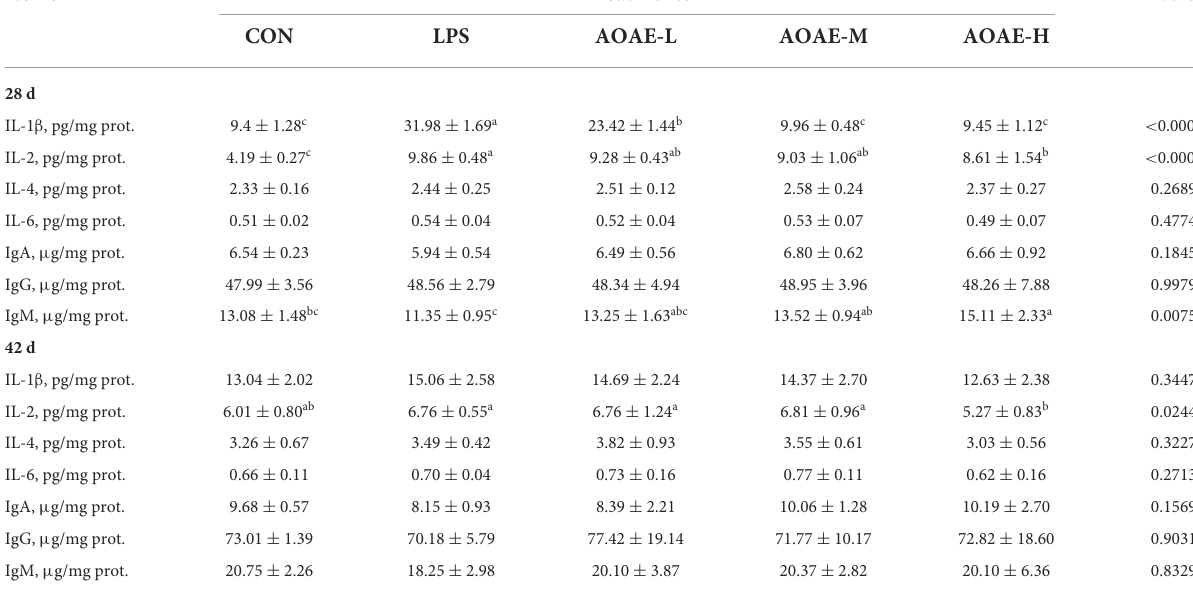
TABLE 6 Effect of AOAE on hepatic cytokines and immunoglobulins in broilers challenged with LPS. Items Treatments P -value CON LPS AOAE-L AOAE-M AOAE-H 28 d IL-1 β , pg/mg